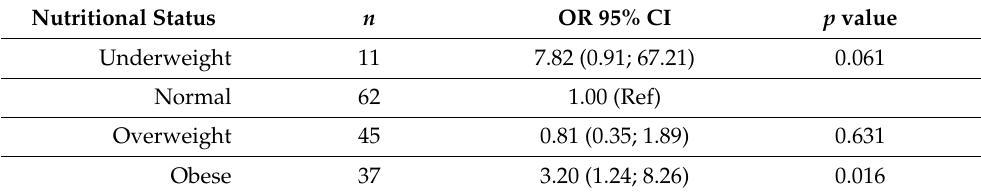
Table 6. Association between sarcopenia and nutritional status, according to Body Mass Index. Nutritional Status n OR 95% CI p value Underweight